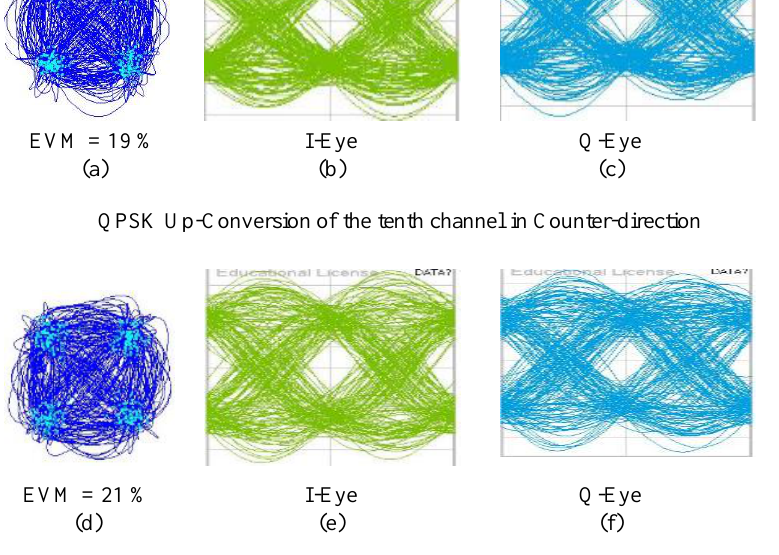
Figure 17. Demodulation of the QPSK up-converted signal at 4 f s + f 10 at BR = 100 Gbit/s. For co-direction ( a – c ), constellation diagram ( a ), I-Eye diagram ( b ), and Q-Eye diagram ( c ). For counter- direction ( d – f ), constellation diagram ( d ), I-Eye diagram ( e ), and Q-Eye diagram ( f ).